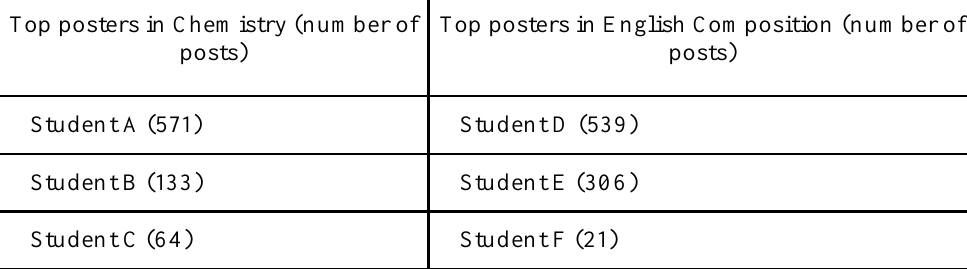
Top Posters in Each Course (All Forum Activity) on Date of Coding Session Top posters in Chemistry (number of Top posters in English Composition (number of posts)